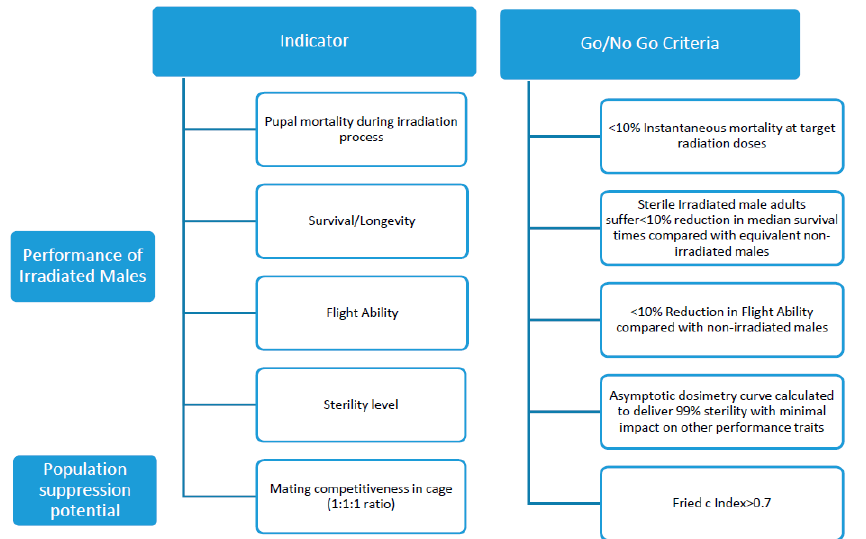
Figure 3. Laboratory studies for evaluating the entomological efficacy of the sterile insect technique (SIT) through the phased conditional testing process in line with the World Health Organization and the International Atomic Energy Agency “Guidance Framework for Testing the Sterile Insect Technique as a Vector Control Tool against Aedes -Borne